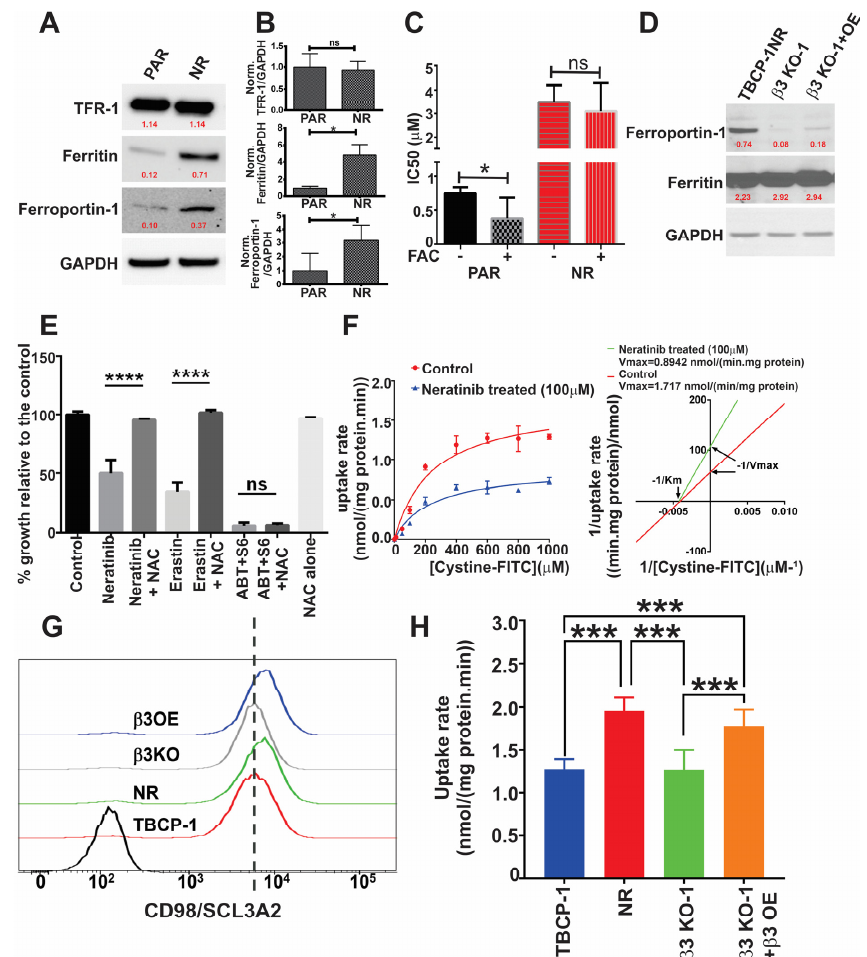
Figure 5. Integrin β 3 modulates iron metabolism and antioxidant response in TKI-resistant cells. ( A ) Changes in the basal expression of iron metabolism effectors were analysed in the age-matched sen- sitive (PAR) or resistant (NR) TBCP-1 cell lysates by Western blot and GAPDH was used as loading control. The intensity ratio of each band relative to GAPDH is indicated in red. The data show rep- resentative blots and ( B ) normalised expression relative to GAPDH ± SD from three independent lysates ( n = 3). Statistical significance was determined by paired t -test, p < 0.05 was considered sig- nificant, * p < 0.05, ns = not significant. ( C ) The impact of addition of exogenous iron (500 µM Ferric Ammonium Citrate, FAC) on neratinib sensitivity of TBCP-1 or TBCP-1NR cells was determined using a 3-day SRB assay. Data shows mean IC50 ± SD from three independent experiments ( n = 3). Statistical significance was determined using a non-parametric Wilcoxon matched-pair t -test, ns = not significant, * p < 0.05. ( D ) Changes in the basal expression of ferroportin-1 and ferritin were analysed in TBCP-1NR control or integrin β 3 KO or OE whole cell lysates by Western blot and GAPDH was used as loading control. The intensity ratio of each band relative to GAPDH is indi- cated in red. The data show representative blots from two independent experiments ( n = 2). ( E ) Neratinib (0.3 µM) or Erastin (5 µM)-induced cell death in TBCP-1 cells was prevented by the